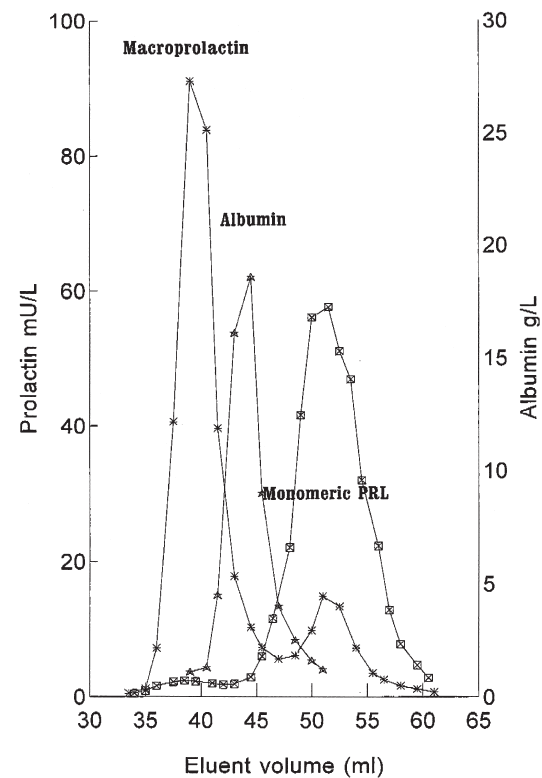
Figure 1 Gel filtration chromatography of serum prolactin in a female patient with macroprolactinaemia (pat. 1, ✳ ) and a con- trol person ( ❑ ). Albumin peak ( ✩ ) as marker for molecular